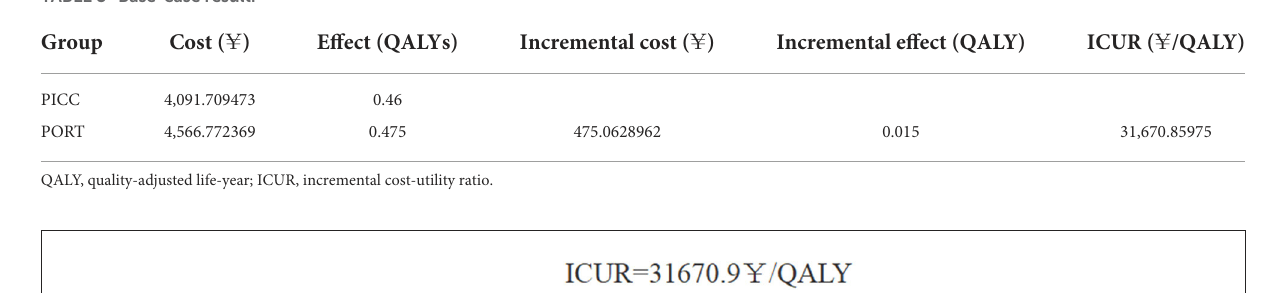
TABLE 5 Base-case result.